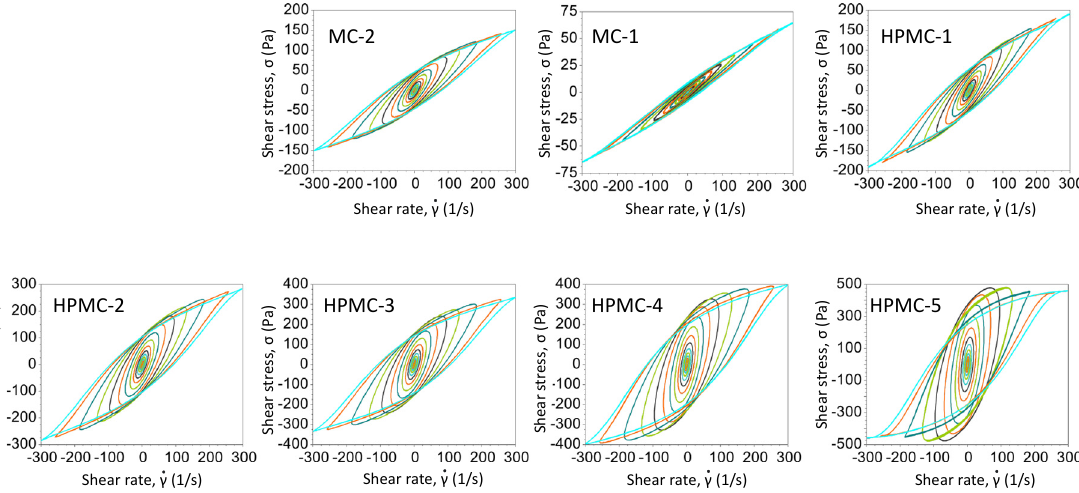
Figure 8. Lissajous–Bowditch curves for HPMC-1, HPMC -2, HPMC-3, HPMC-4, HPMC-5, MC-1, and MC-2.